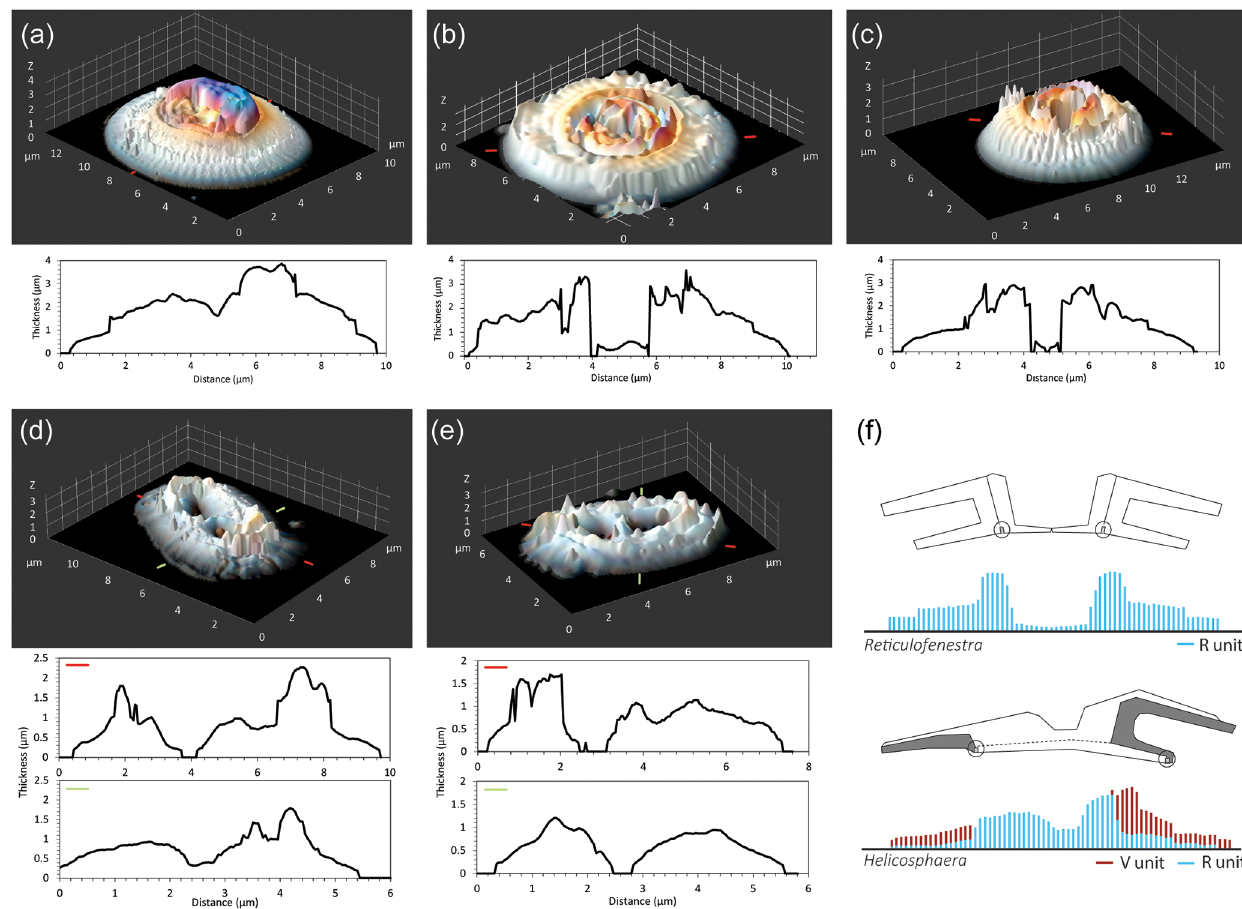
Figure 8. Sample of accumulated thickness schemes overlapped with color images and cross-section profiles for Reticulofenestra bisecta (a) , Cyclicargolithus floridanus (b–c) from U1406A, and Helicosphaera carteri (d–e) from 905. (f) Thickness representation of two main coc- colithophore groups used here from its cross-section shape schemes modified from Young et al.